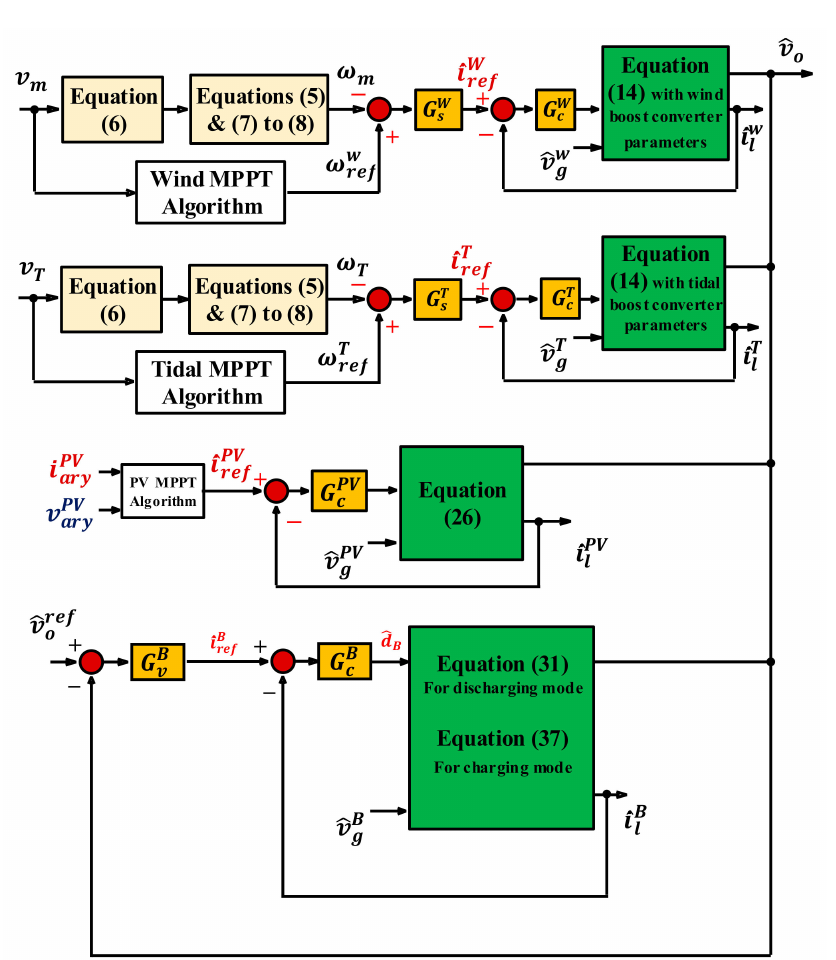
Figure 14. Overall model of a floating structure with tidal, wind, solar and battery